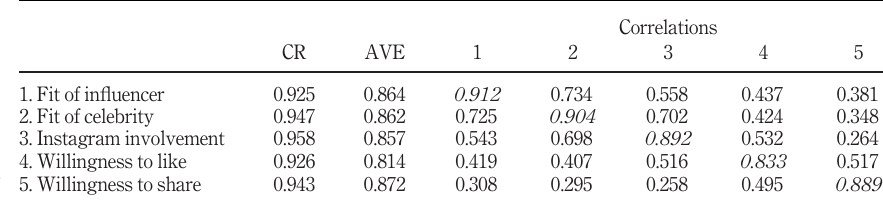
Table 1. Composite reliability, the AVE and item- total correlations of per